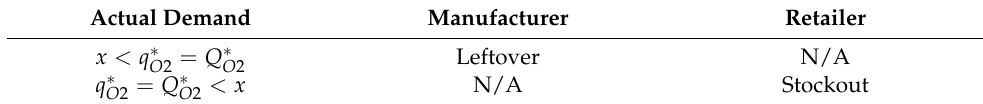
(cid:0) (cid:1) c 0 , c e , q ∗ , Q ∗ O 2 O 2